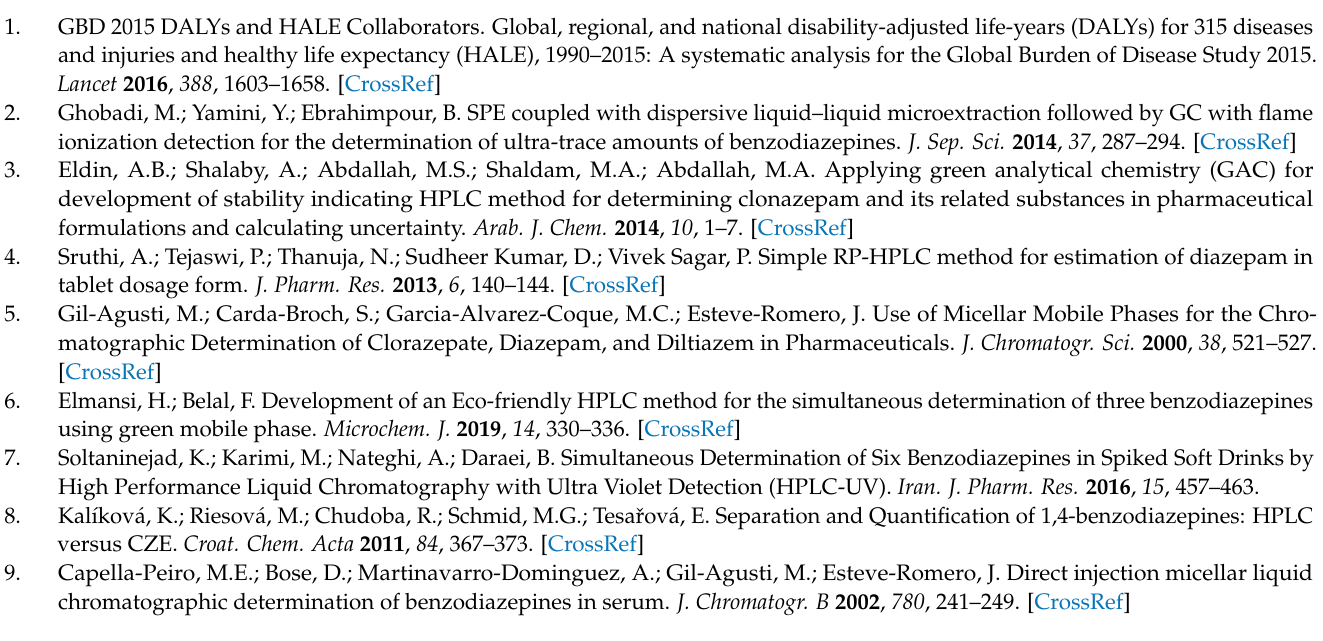
Figure S2: Chromatogram of clonazepam, Figure S3: Chromatogram of lorazepam, Figure S4: Chromatogram of nordiazepam, Figure S5: Chromatogram of diazepam, Table S1: Short and long term storage recoveries (%) and